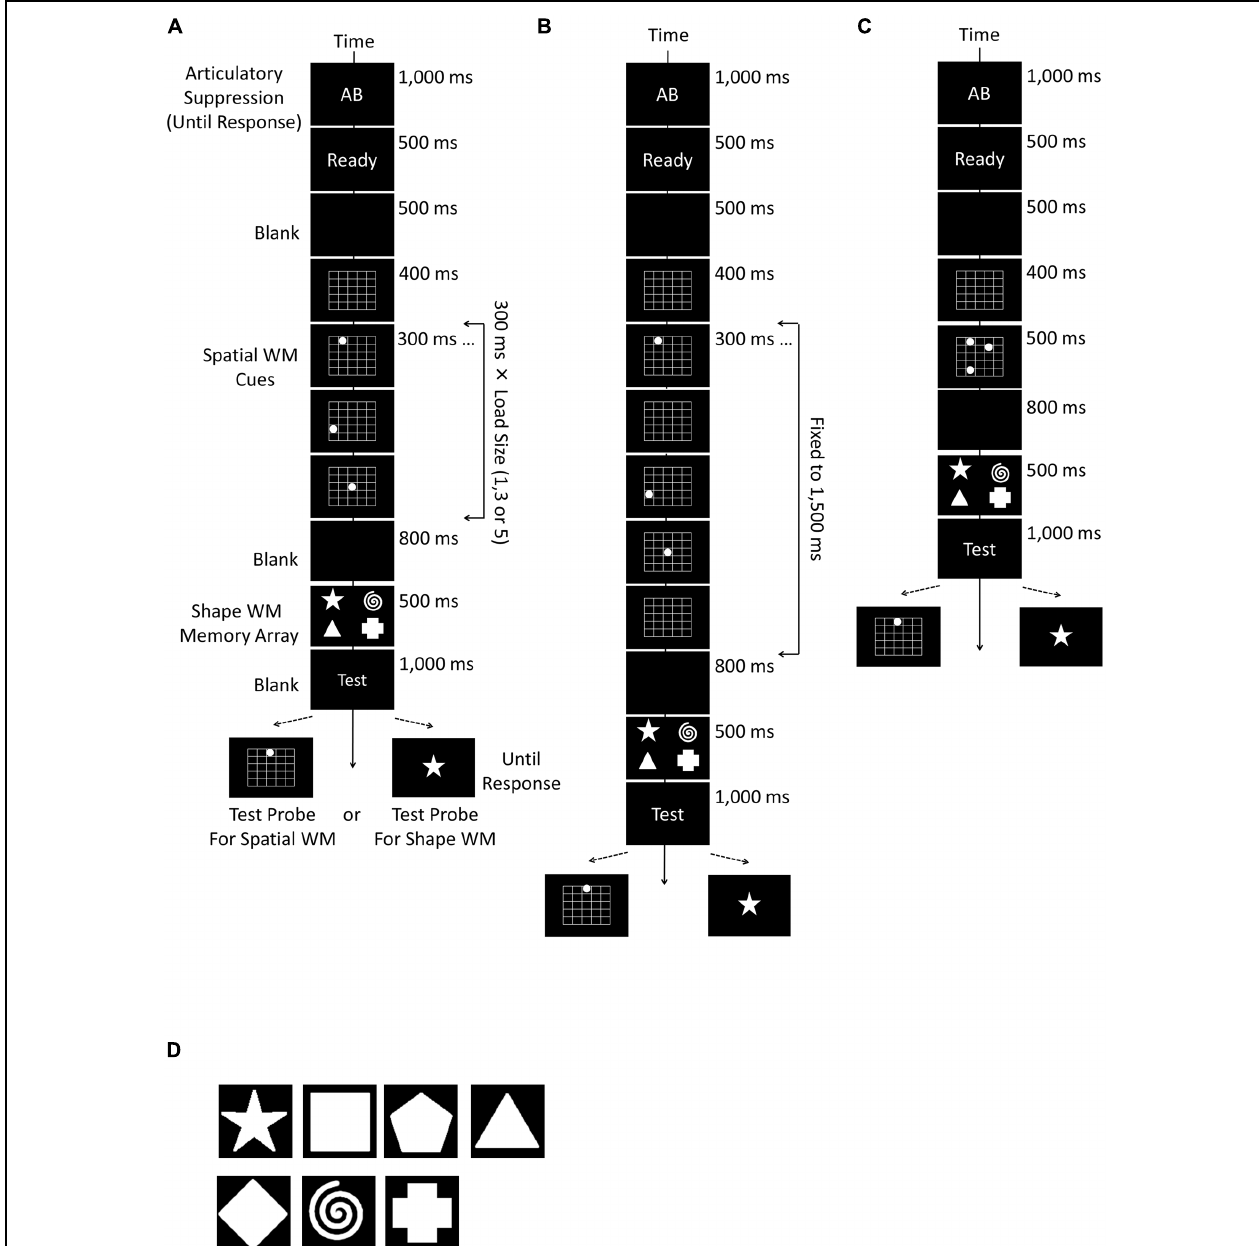
FIGURE 1 | Schematic diagrams of the experimental procedures used in Experiments 1a (A), 1b (B), and 1c (C). In all experiments, a trial consisted of the instruction of articulatory suppression, spatial working memory (WM) cues, first blank, shape WM array, second blank, and the test probe. Spatial WM was tested in the half of trials, and shape WM in the rest of trials. The load size of spatial WM randomly changed from 1, 3, to 5, but